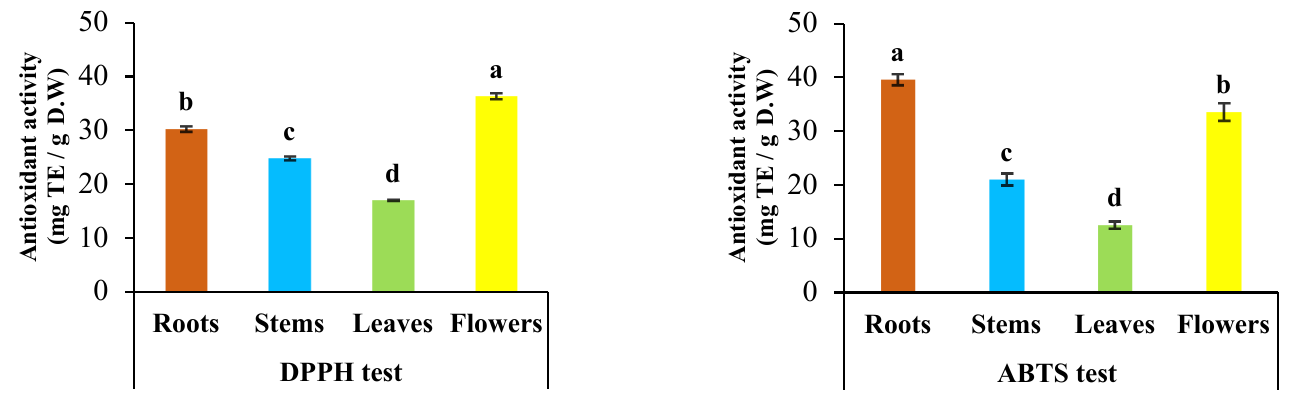
Figure 5. Antioxidant activity of different organ extracts of Cladanthus mixtus by the DPPH and ABTS tests. Different letters indicate significant differences between the organs of one plant at p < 0.05. Values are means ± S.D. for three replicates.